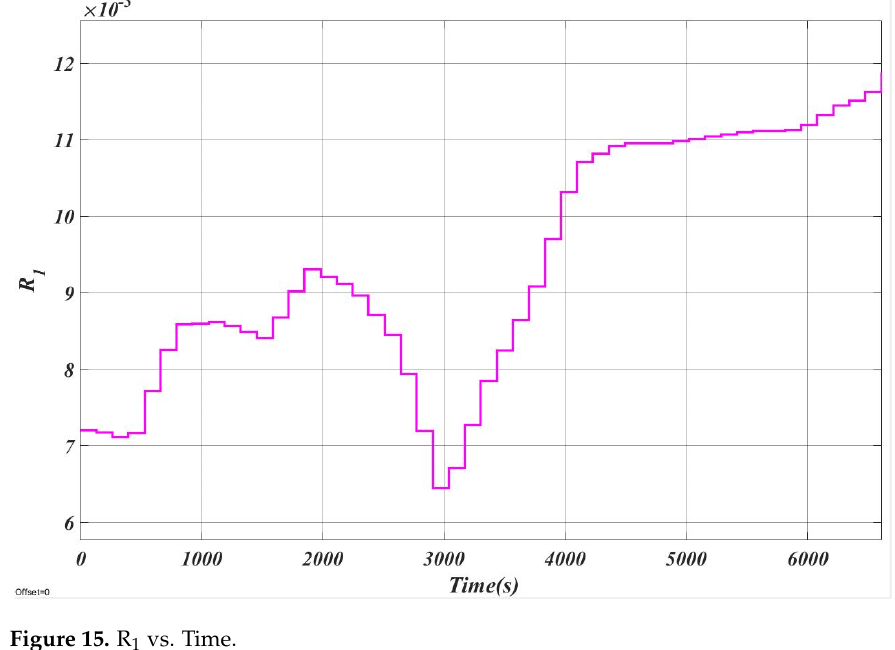
Figure 15. R 1 vs. Time.